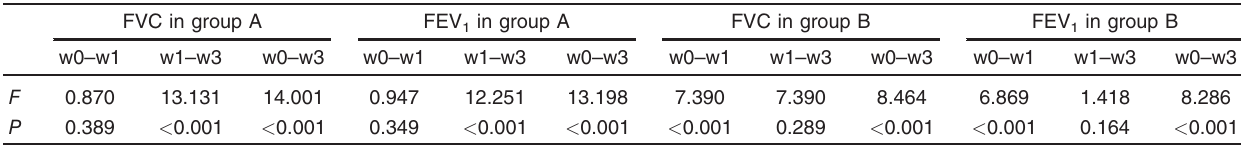
Table 4 Comparison between spirometric changes before, after 1 week, and after 3 weeks in both groups